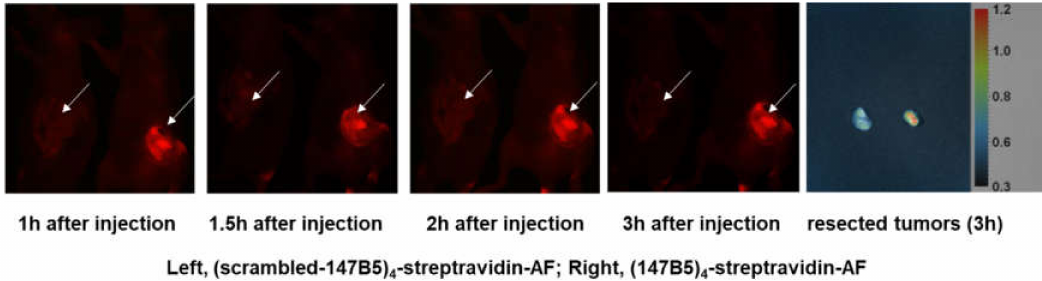
Figure 6. (147B5) 4 -streptavidin-AF accumulates in pancreatic cancer. Mice harboring orthotopic human pancreatic cancer BxPC3-GFP (white arrows) were treated with either (147B5) 4 -streptavidin-AF or its control (scrambled-147B5) 4 -streptavidin- AF (100 µ L, via tail vein, 10 mg/kg) and images were taken at various time